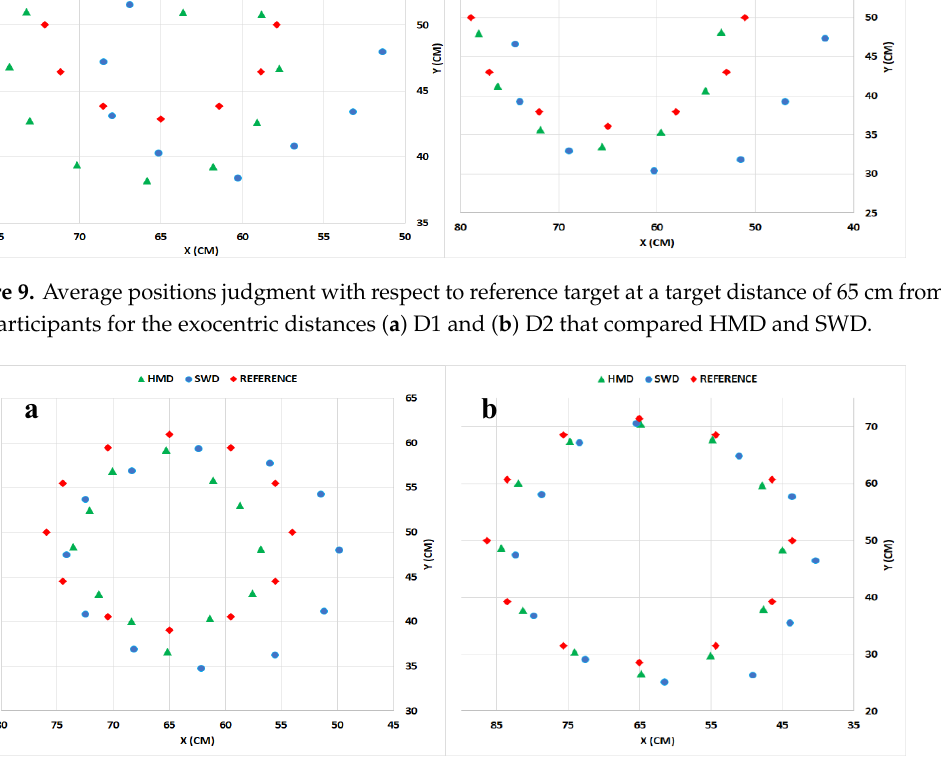
Figure 10. Average positions judgment with respect to actual (reference) target at a target distance of 100 cm from the participants for the exocentric distances ( a ) D3 and ( b ) D4 that shows a comparison between HMD and SWD.